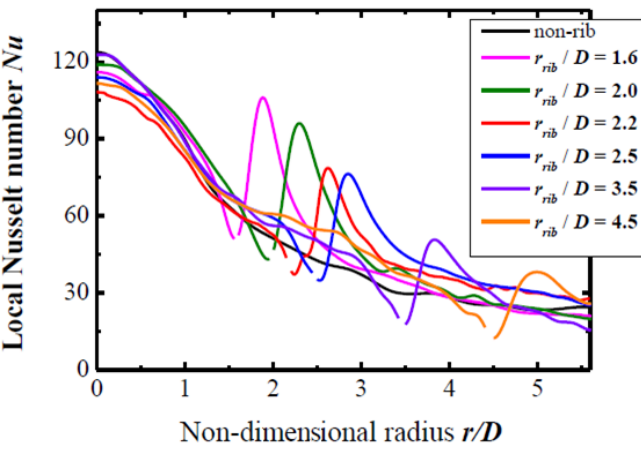
Figure 7. Effect of the circular rib locations on local Nu (at the fixed circular rib height of e / δ = 1.0).